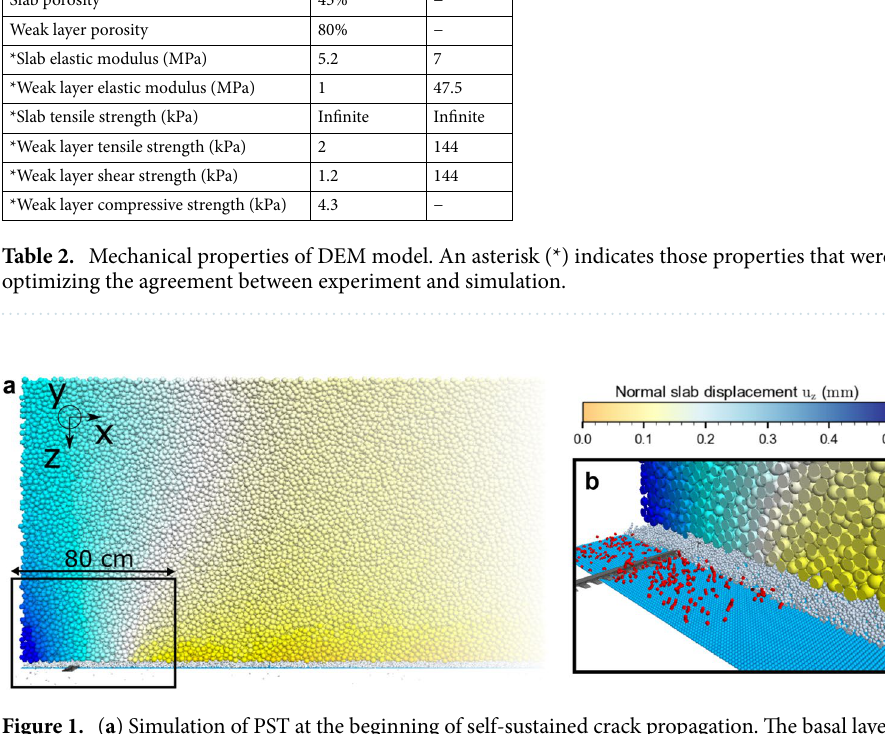
Figure 1. ( a ) Simulation of PST at the beginning of self-sustained crack propagation. The basal layer is represented in light blue ( r = 2.5 mm), the weak layer (WL) in white ( r = 2.5 mm), and the slab layer is colored by its normal displacement [colored from no displacements in yellow to 0.5 mm displacement in blue, r = (10.5 ± 0.5) mm]. The snow saw is represented in dark grey. ( b ) Internal WL fracture process around the fracture process zone (WL and slab were removed from the visualization). Red necks represent broken bonds in the weak layer. At the beginning of self-sustained crack propagation, many bonds are breaking ahead of the saw